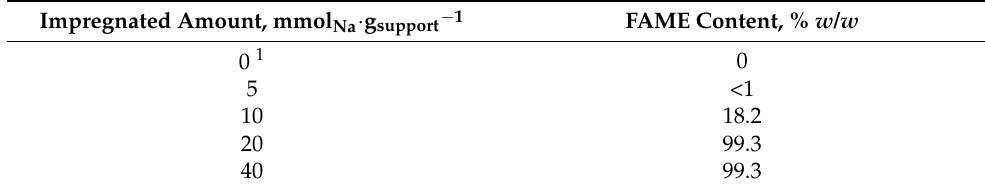
Table 1. Activity tests of NaNO 3 /SiAl catalysts. Experimental conditions: methanol/oil ratio, 9:1; temperature, 65 °C; catalyst amount, 7% w / w ; stirring rate, 700 rpm; reaction time, 180 min. Impregnated Amount, mmol Na ·g support−1